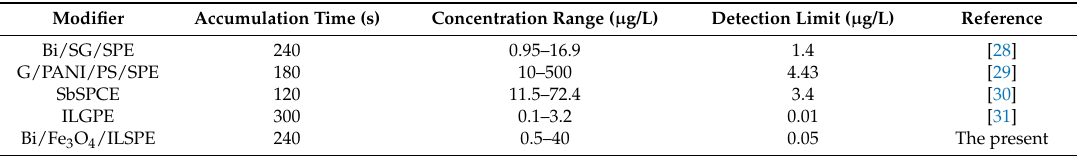
Table 2. Comparison with other electrodes for Cd(II) detection.